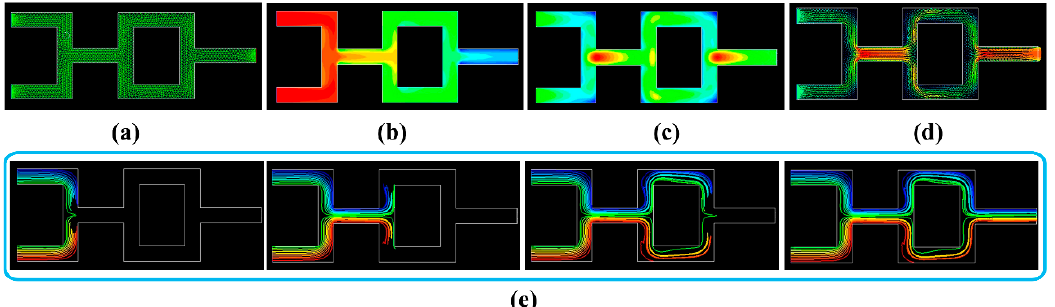
Figure 13. Simulated 2D cross-section flow field of the fluid mixing model: ( a ) mesh model; ( b ) total pressure contour; ( c ) turbulent intensity contour; ( d ) velocity vector; and ( e ) partial pathlines at different steps colored by particles.